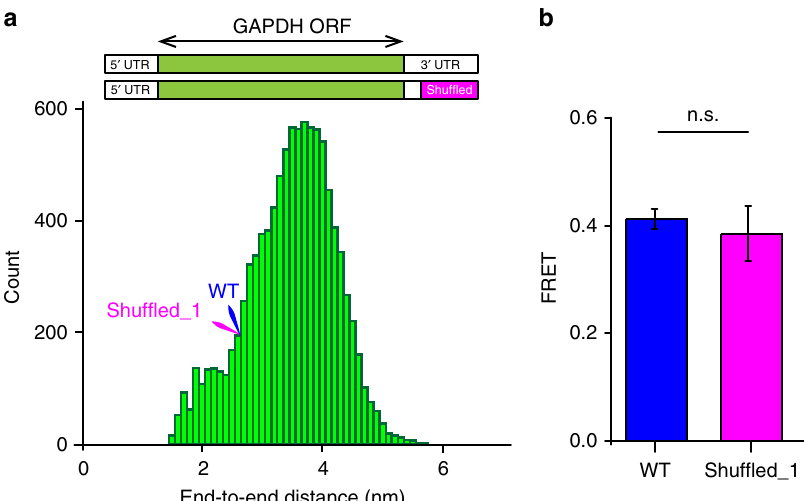
Fig. 4 RNA end-to-end distance is largely sequence independent. a Distribution of average end-to-end distances in 10,000 GAPDH mRNA variants, in which 106 3 ′ terminal nucleotides were shuf fl ed. Predicted end-to-end distances in wild-type and shuf fl ed_1 GAPDH mRNAs are indicated by blue and pink arrows. b Ensemble FRET values measured in wild-type (blue) and shuf fl ed_1 (pink) GAPDH mRNA variants. Each FRET value represents the mean ± SD of three independent experiments. The difference between FRET values was not statistically signi fi cant (n.s.) as determined by the Student t -test with α of 0.05